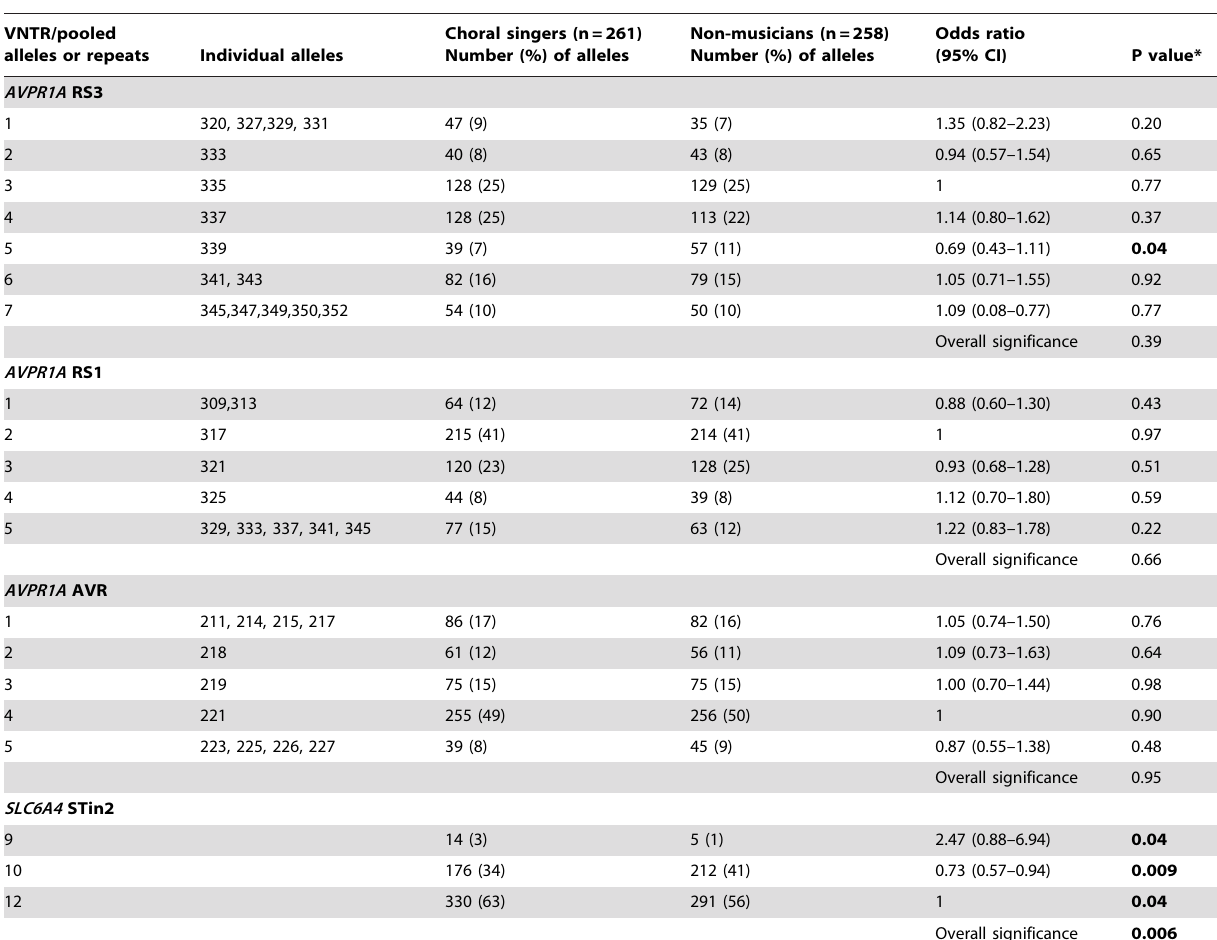
Table 1. Association of AVPR1A and SLC6A4 VNTRs with singer/non-musician status.